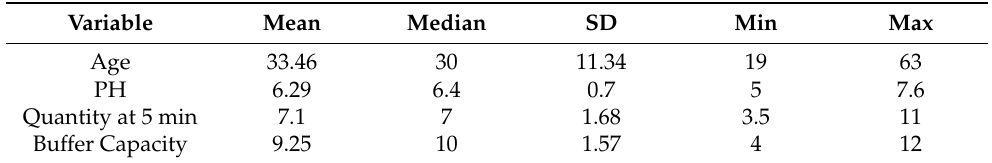
Table 2. Statistical results referring to the saliva quantity at 5 min, salivary pH, and buffering capacity in the entire studied population.